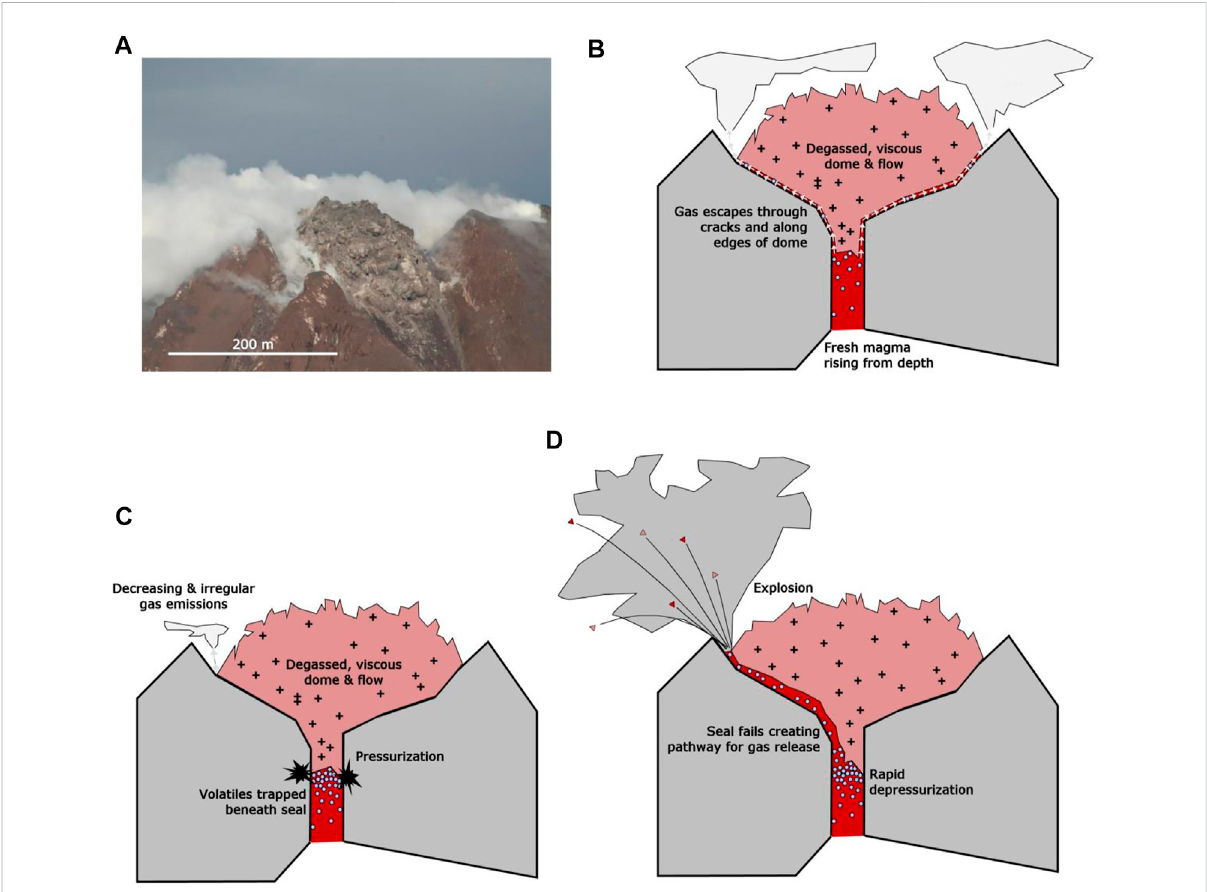
FIGURE 4 Schematic of our conceptual seal-failure model for magmatic degassing and explosions at Sinabung. (A) Photograph by CVGHM scientists of thelavadomeperchedinSinabungVolcano ’ ssummitcrateron25November2020.Degassingdominantlyoccursfromthemarginsofthedome. (B) During periods ofexplosive quiescence,gases exsolvingfrom magmarisingintheconduit escapethroughcracksinand pathways aroundthehighly viscous and relatively impermeable lava dome. (C) If the degassing pathways become sealed, SO 2 emissions decrease and gas accumulating beneaththedomebeginstopressurize.Highlyvariablegasemissionsmayresultifthesealisbrokenintermittentlyinanon-explosivemannerbefore a critical pressure is achieved. (D) Explosions occur if the pressure builds beyond the threshold for generating new or re-establishing preexisting degassing pathways. Explosions are caused by the rapid depressurization of the shallow conduit. The magnitude of the resulting explosions will depend on the strength of the seal, which determines the accumulated pressure beneath